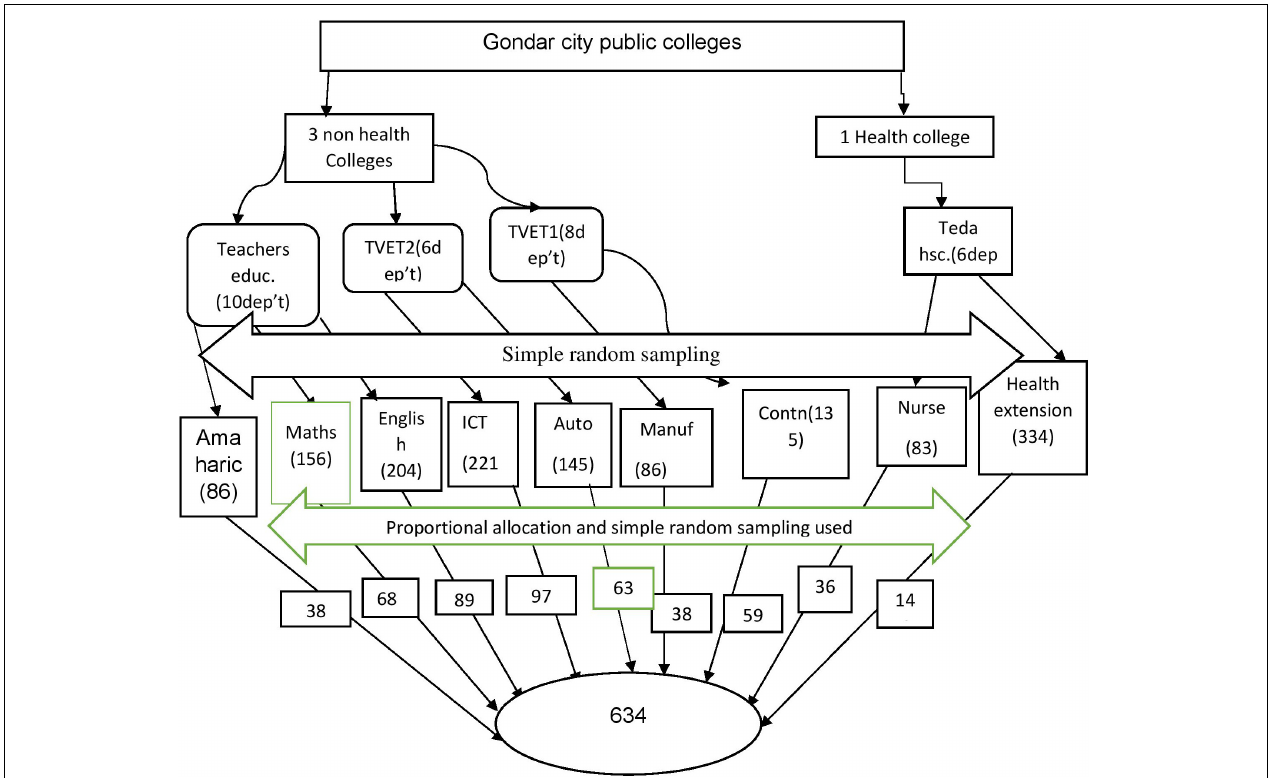
FIGURE 1 | Schematic presentation of the sampling procedure to assess COVID-19 vaccine and associated factors among college students in Gondar city, northwest Ethiopia, 2021.